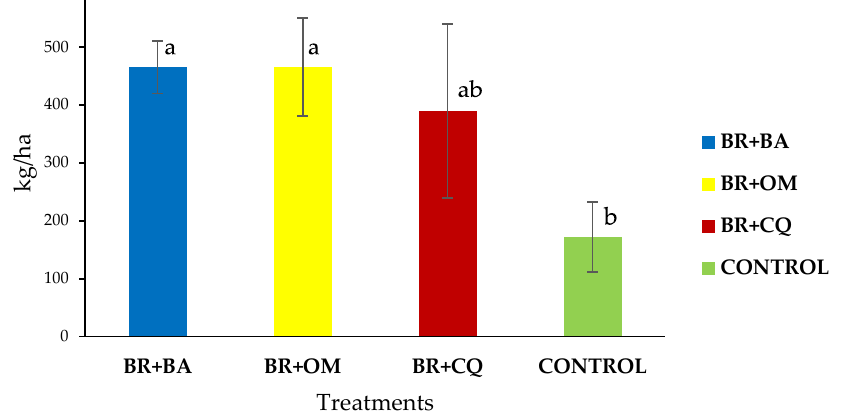
3.5. Grain Yield